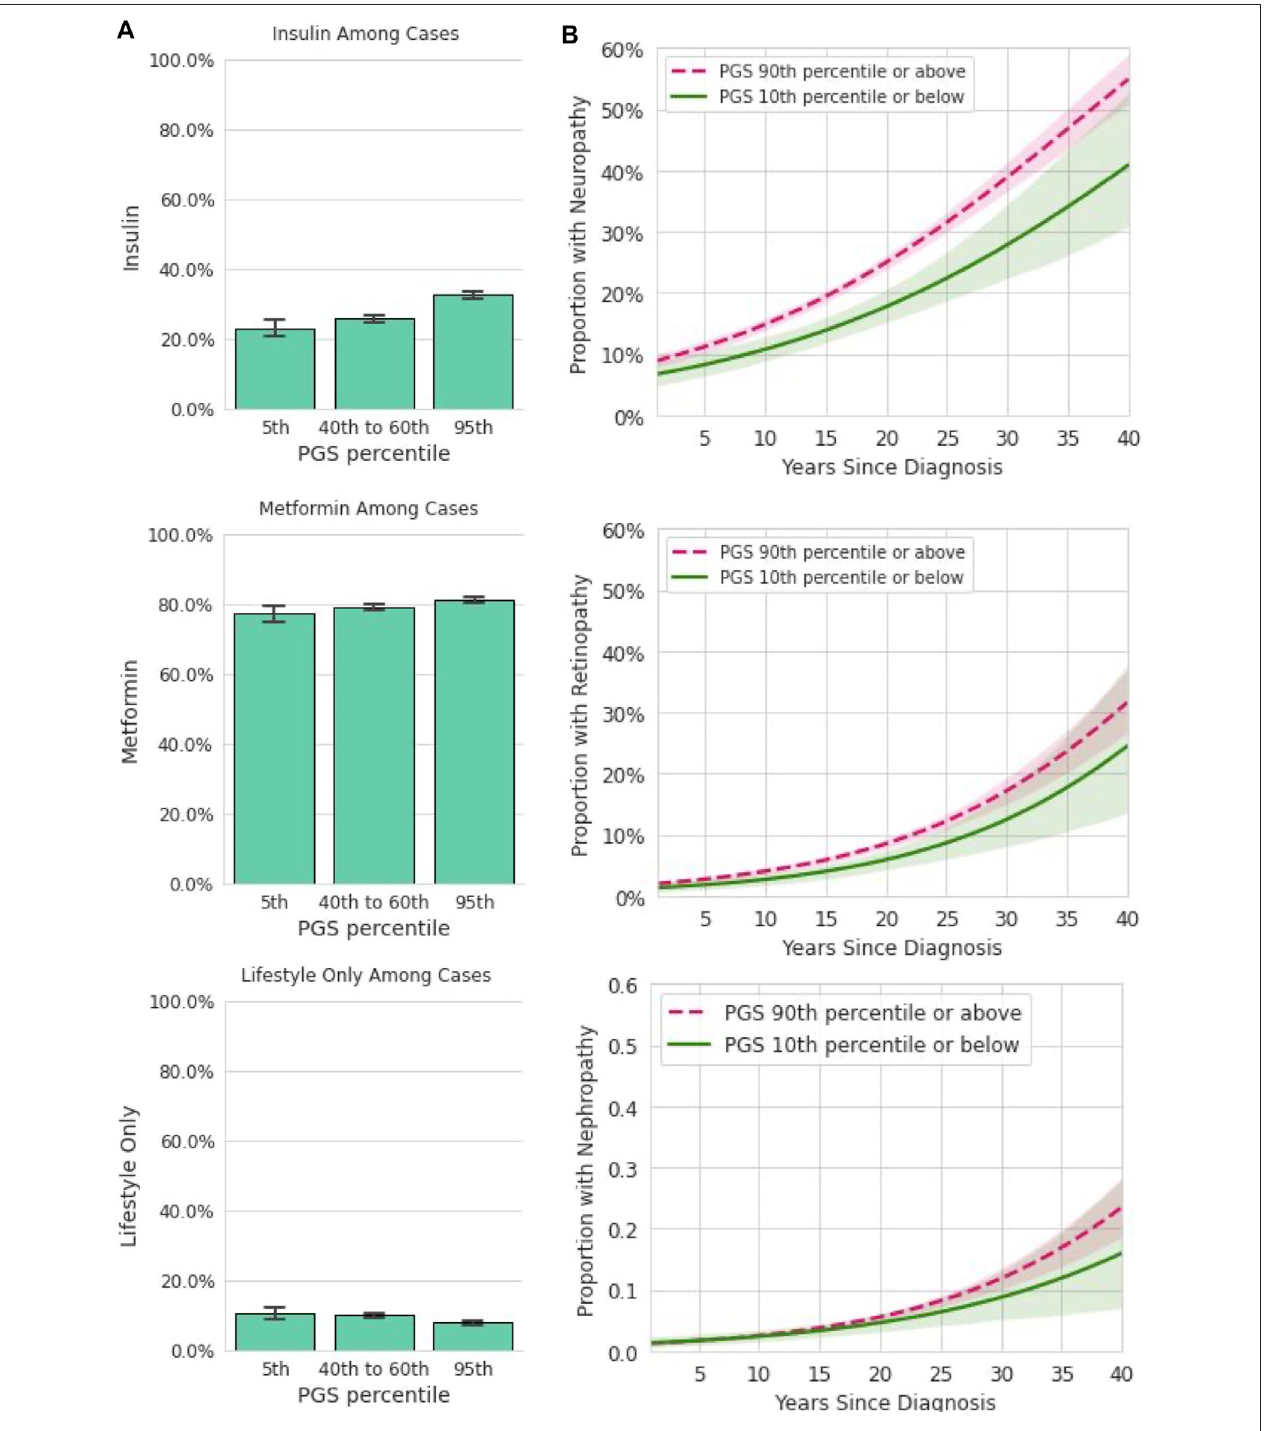
FIGURE 4 | Among participants with T2D, the PGS is associated with some forms of treatment and disease complications. (A) : In a dataset restricted to participants who reported aT2Ddiagnosisand provided informationon prescribed treatments, insulin, metformin, and lifestyleonly are plotted (y-axis) forparticipants in the 5th, 40 – 60th, and 95th percentiles of the PGS (x-axis). Error bars represent empirically derived 95% con fi dence intervals. Insulin prescriptions were signi fi cantly associated with the PGS in multivariate models controlling for age, sex, BMI, and family history of T2D. (B) : Data shown are the relationship between years since T2D diagnosis and microvascular complications, strati fi ed by PGS percentile in a logistic model. Shaded areas represent 95% con fi dence intervals. Neuropathy was signi fi cantly associated with the PGS in multivariate models controlling for age, sex, BMI, and family history of T2D.